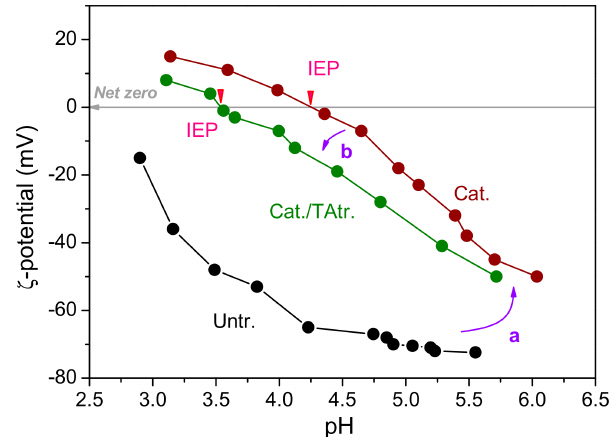
Figure 3. Surface ζ -potential change of Untr., Cat., and Cat./TAtr. cotton as a function of pH value. Note: Untr.: untreated; Cat.: cationised; Cat./TAtr.: